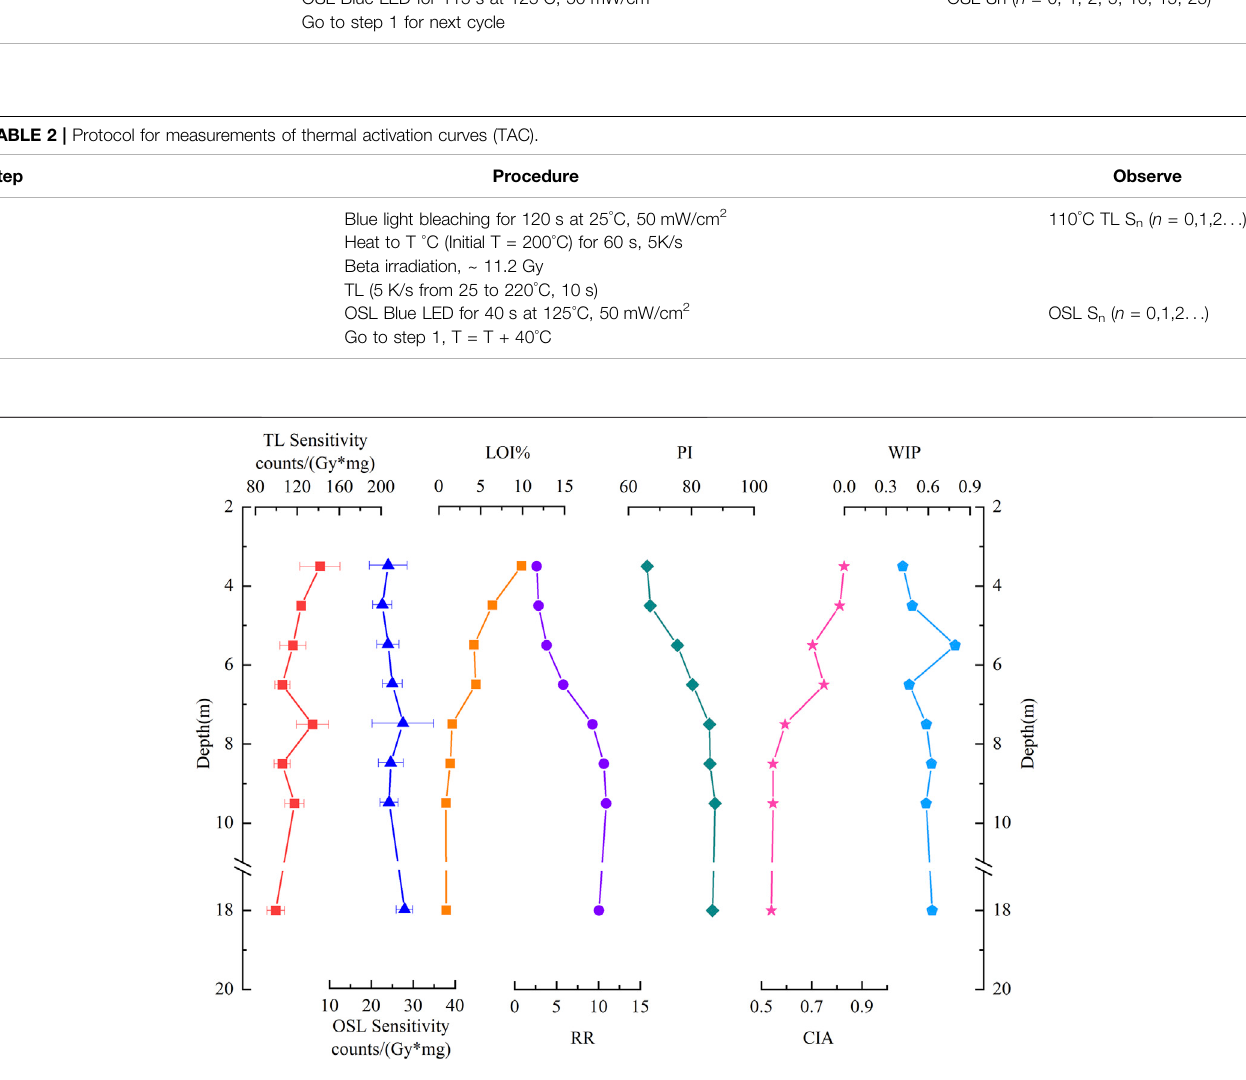
FIGURE 2 | The QLS changes with depth in the Sanming borehole and its relationship to different chemical weathering indices. The calculation of weathering indicesislisted in Table 4 ,including Loss onIgnition(LOI),Ruxton Ration (RR),ProductionIndex (PI),Chemical Index ofAlteration (CIA), and Weathering Index ofParker (WIP). The error bar denotes the standard deviation of TL and OSL sensitivity. Please note the gap between 10 and 18 m.